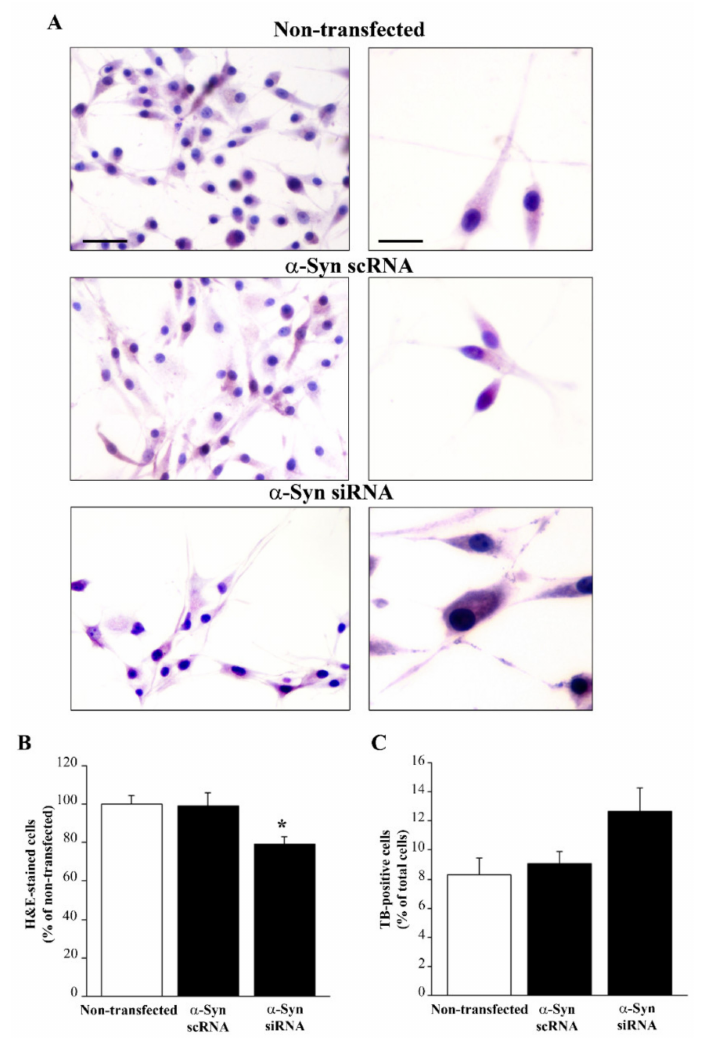
Figure 10. Silencing α -syn did not alter cell viability while producing phenotypic changes. ( A ) Rep- resentative pictures are shown of H&E-stained U87MG cells from non-transfected, α -syn scRNA- transfected, and α -syn siRNA-transfected cells. Graphs report the percentage of H&E-stained cells (considering non-transfected cells to be 100%) ( B ) and the percentage of TB-positive cells among total cells ( C ). Values are given as the mean percentage ± SEM of n = 6 counts obtained in N = 3 independent experiments. * p < 0.05, compared with non-transfected cells. Scale bars = 70 µ m (low magnification); 30 µ m (high